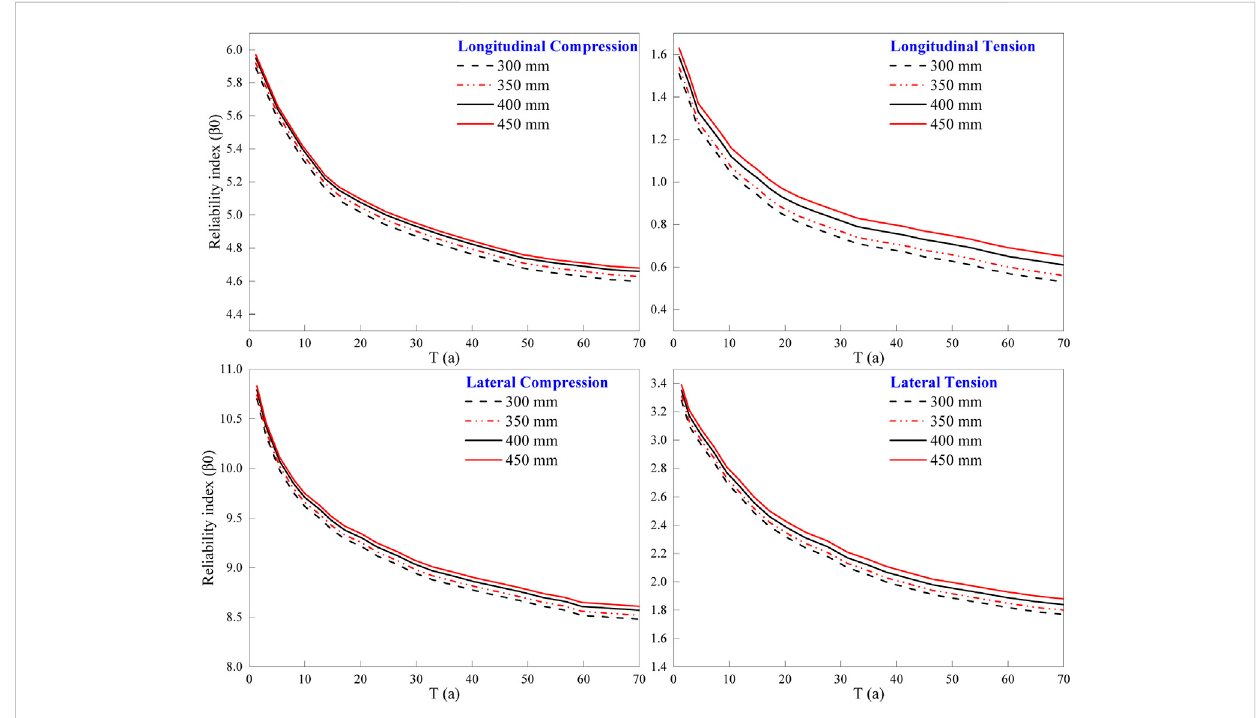
FIGURE 6 Effect of different lining thicknesses on the fatigue reliability of the invert